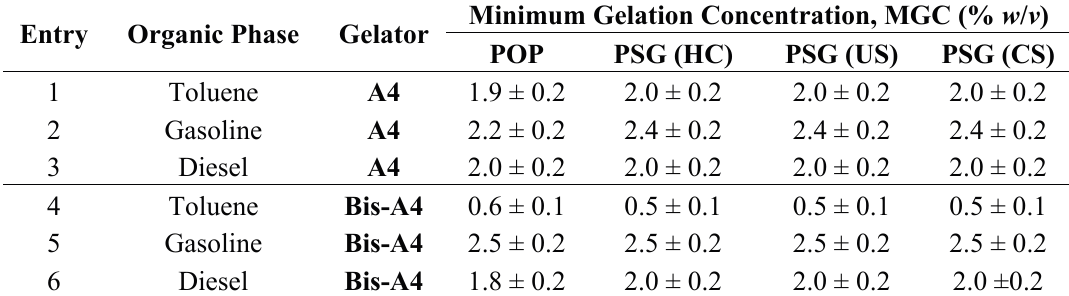
Table 2. Comparison of the MGC necessary to induce PSG in selected oil/water mixtures either by the heating-cooling method (HC), ultrasound treatment of the mixture (US) or by adding an ultrasound-aided concentrated solution of the gelator in an oil-phase to the corresponding oil/water mixture